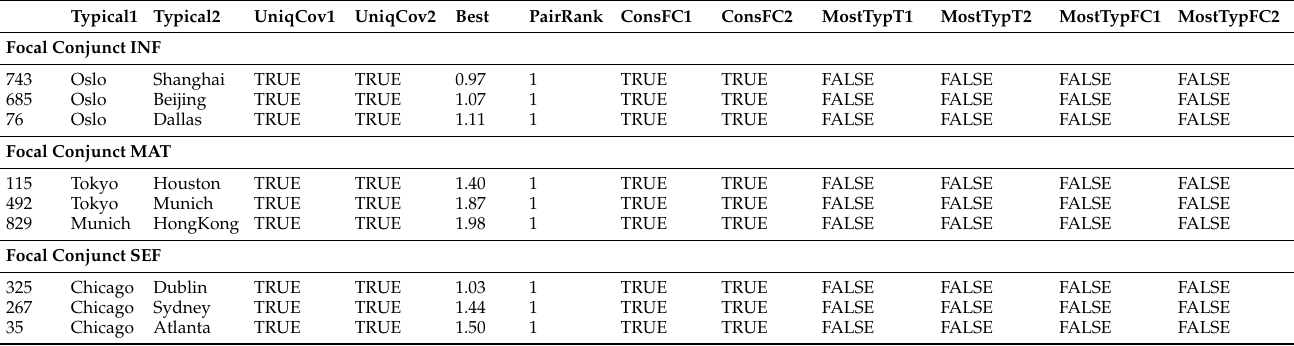
Table 10. Comparative analysis of two typical cases for